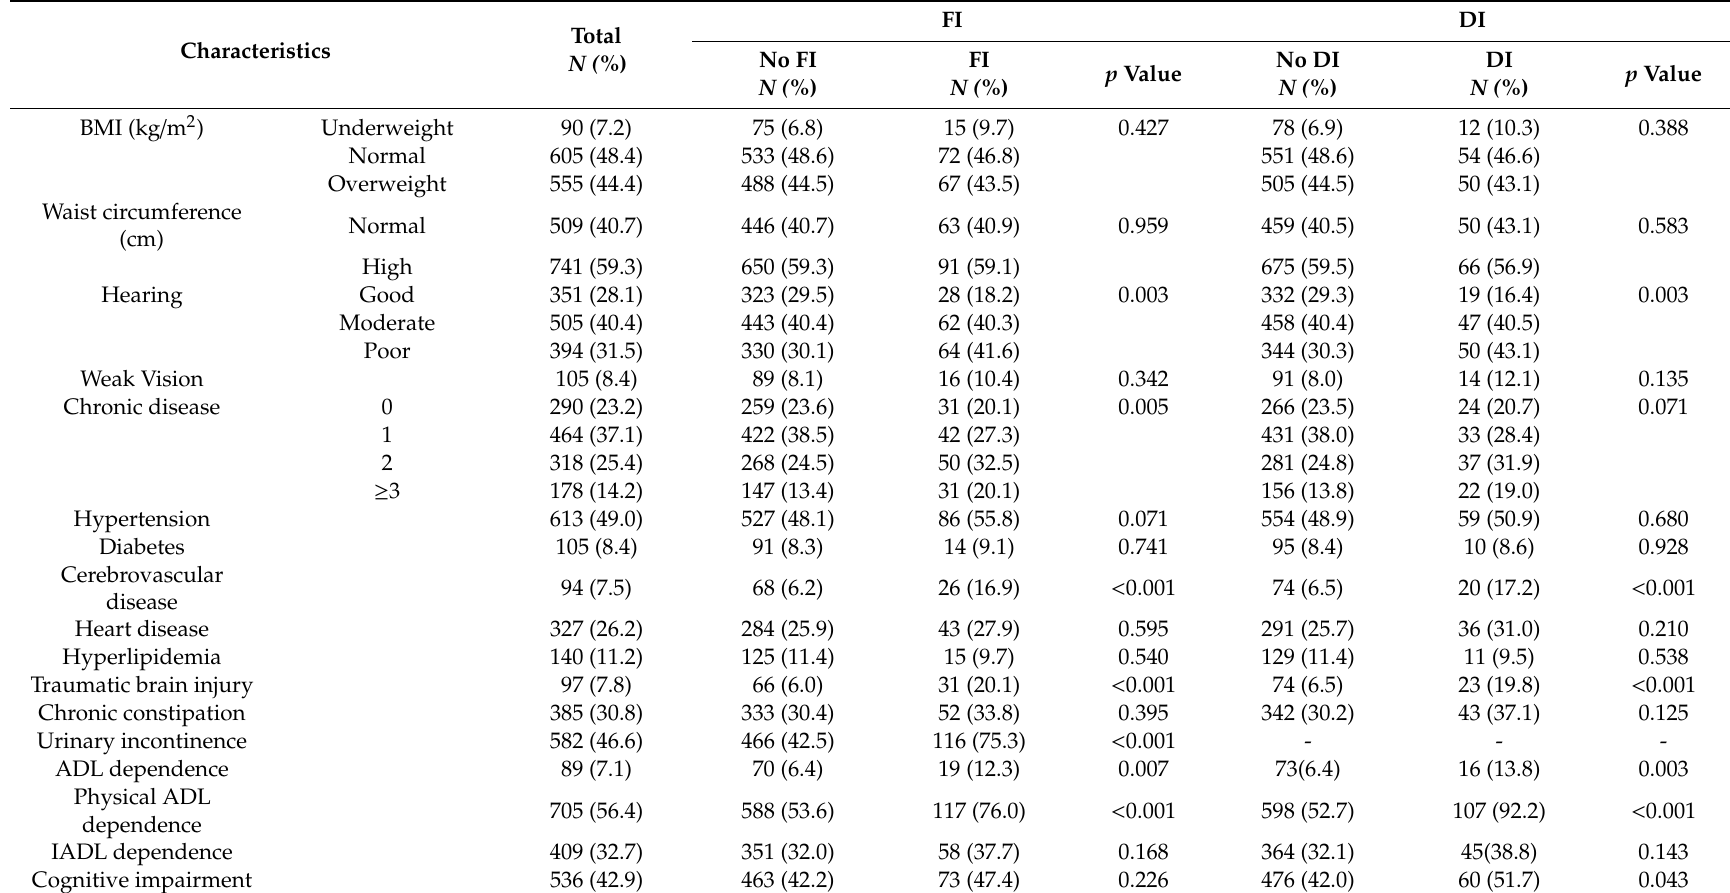
Table 2. Health-related characteristics of study population ( n =